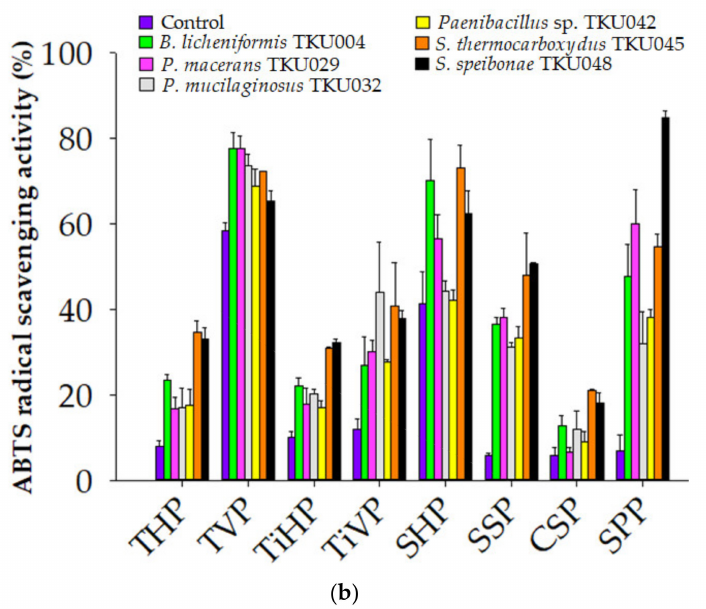
Figure 7. DPPH ( a ) and ABTS ( b ) radical scavenging activity of the hydrolysates produced by crude- enzyme cocktails from different proteolytic bacterial strains. All data points are means ± S.D. of three different experiments (each experiment was conducted in